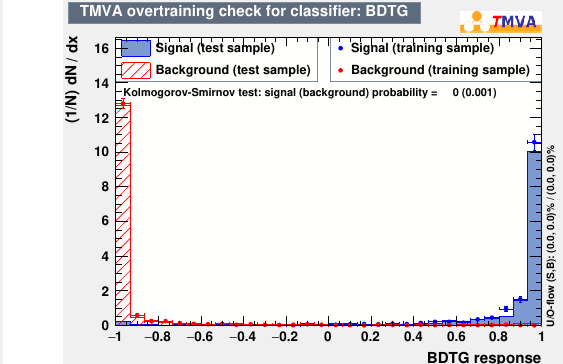
Signal (test sample) Background (test sample)